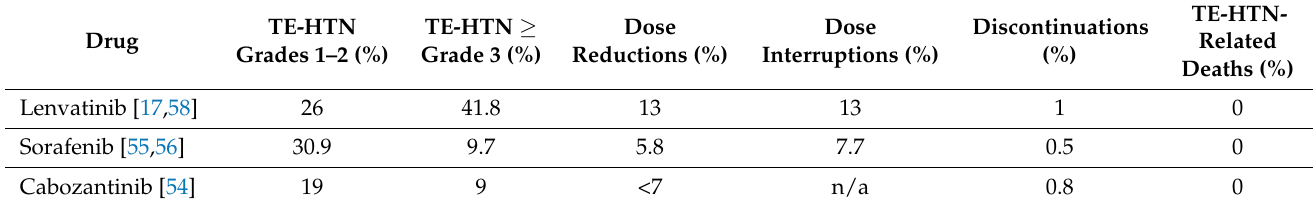
Table 5. Occurrence of TE-HTN and TE-HTN dose